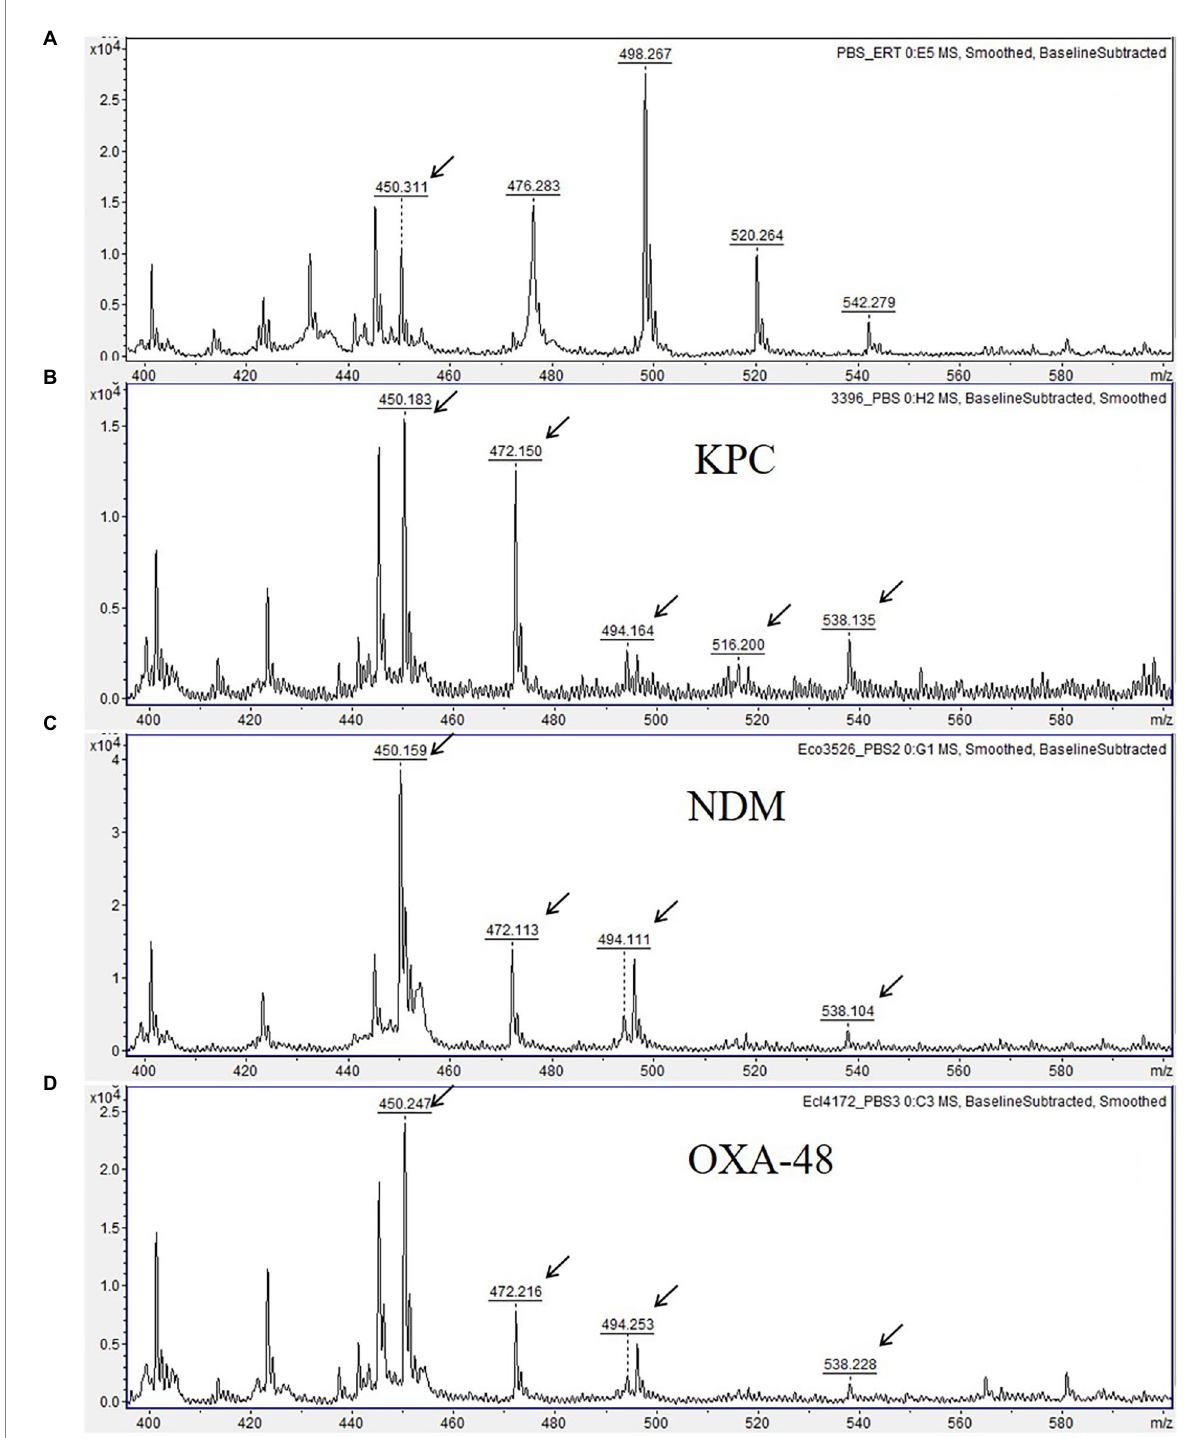
FIGURE 1 Matrix-assisted laser desorption ionization time-of-flight (MALDI-TOF) mass spectra showing ertapenem hydrolysis by carbapenemase-producing Enterobacterales. (A) Mass spectrum of ertapenem disk after 3 h-incubation in 0.01 M PBS, pH 7.4 (negative control). (B–D) Mass spectra showing ertapenem hydrolysis by KPC-3, NDM-1, and OXA-48 carbapenemases. Peaks corresponding to hydrolyzed forms of ertapenem are indicated with arrows. Units on the Y axes represent relative